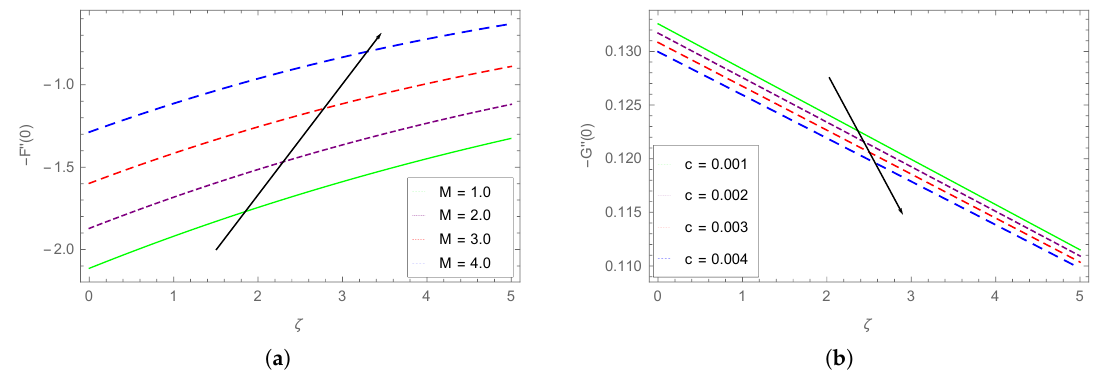
Figure 20. ( a ) The dependence of skin friction ( C fx ) on M . ( b ) The dependence of skin friction ( C fy ) on c .